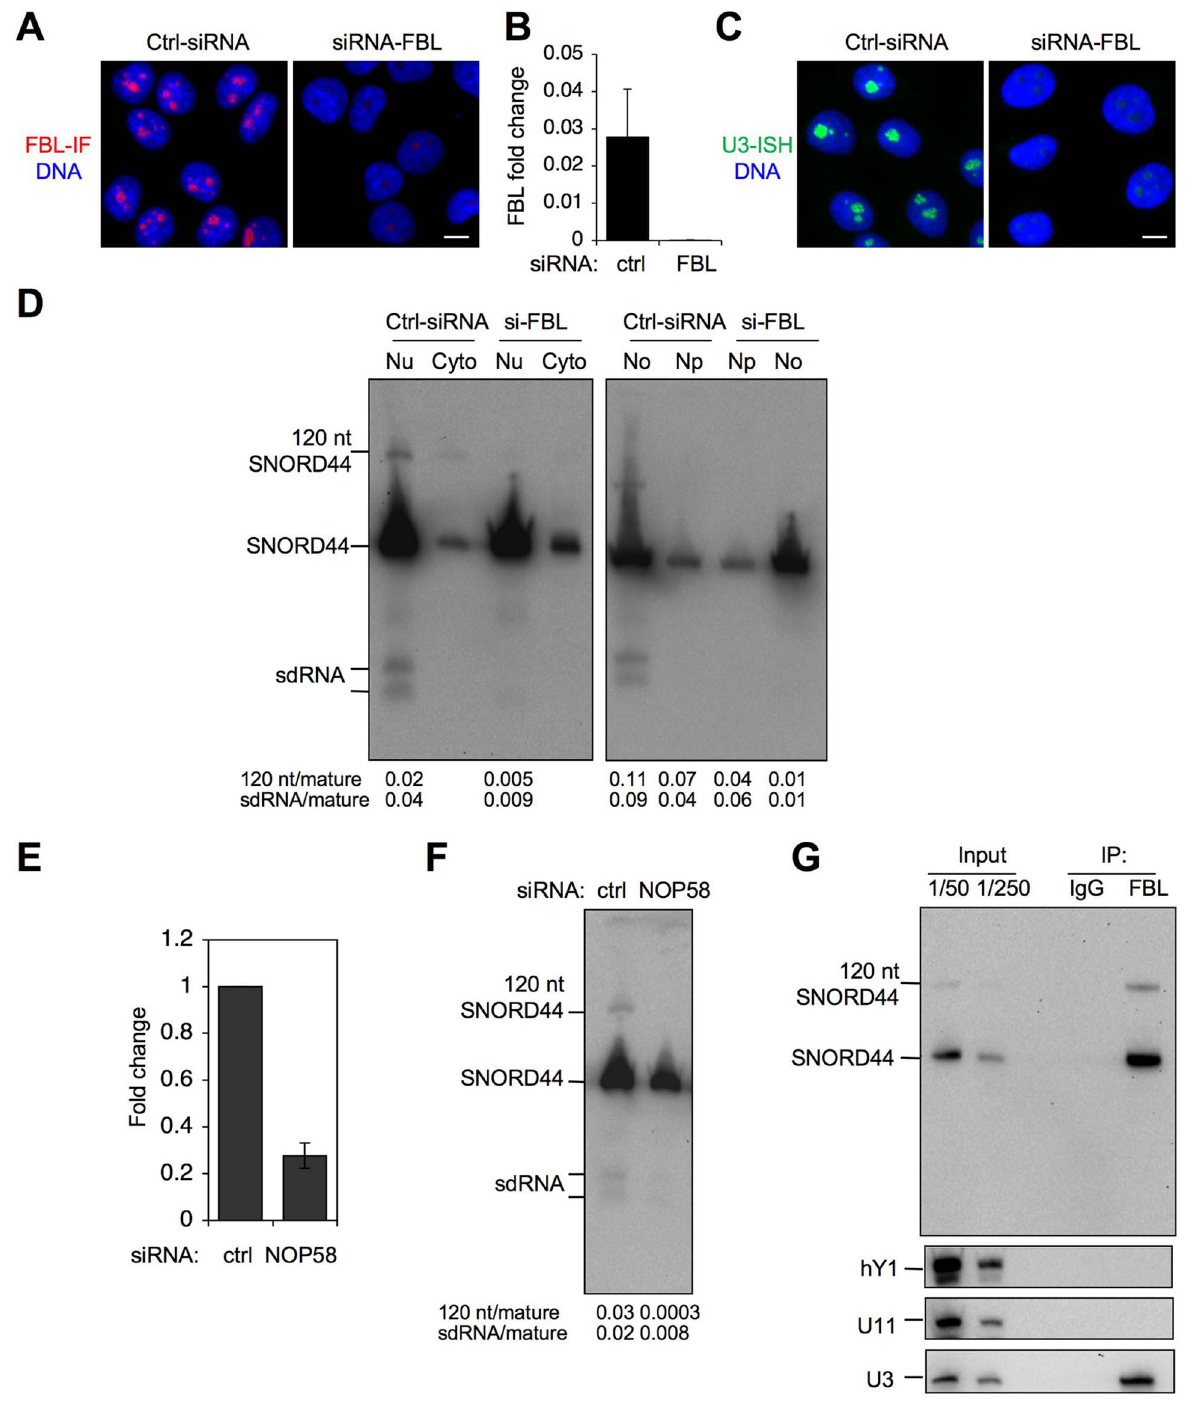
Figure 7. Expression of the SNORD44 sdRNA and long forms depends on FBL and NOP58. ( A–D ) HeLa cells were transfected with control or FBL-targeting siRNAs and incubated for 48 hours. A Cells were fixed and stained for FBL and counterstained for DNA. Merged images are shown. Scale bar, 10 m m. B Image quantification for FBL. Mean normalized fold intensity is shown. Error bars, SD. C In situ hybridization of U3 snoRNA. Scale bar, 10 m m. D Nuclear (Nu, containing nucleoli), cytoplasmic (Cyto), nucleoplasmic (Np) and nucleolar (No) fractions were prepared, and RNA was isolated. Northern hybridization was conducted using SNORD44 5 9 probe. Signal intensities for 120 nt and sdRNAs were quantified and normalized against the mature SNORD44. ( E, F ) HeLa cells were transfected with control or NOP58-targeting siRNA and incubated for 48 hours. E Expression of NOP58 transcript was determined by qPCR. F Northern blotting was conducted for SNORD44 as in D. G FBL was immunoprecipitated from HeLa nuclei, followed by isolation of RNA and Northern hybridization using SNORD44, hY1, U3 and U11 probes. IgG was used as negative control in the immunoprecipitation. Inputs represent fraction of RNA present in the nuclei used for the pull-down.